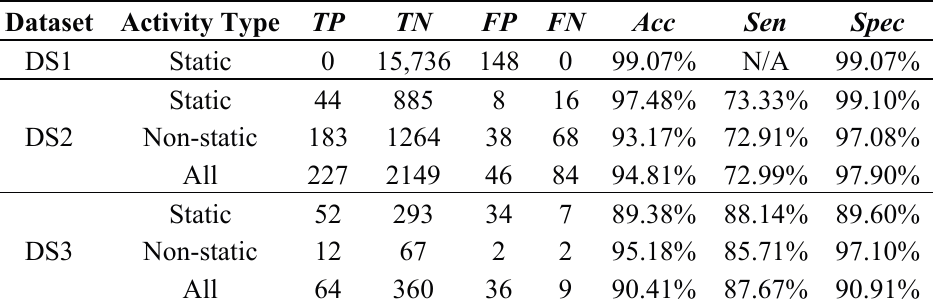
Table 11. Evaluation results: Signal quality